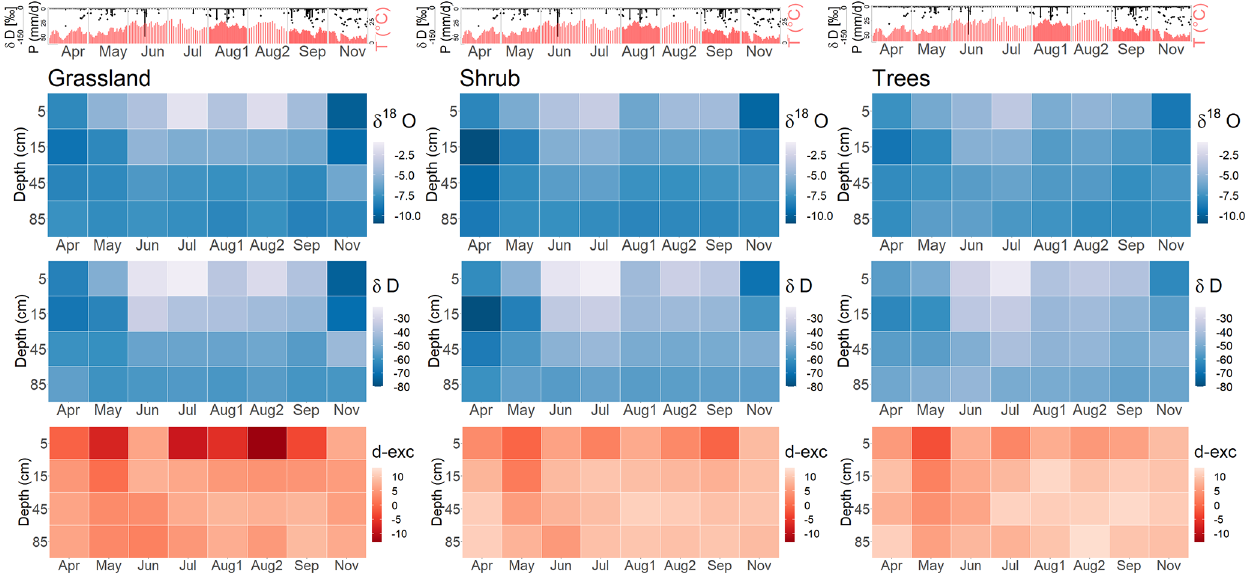
Figure 5. Heat maps showing the isotopic composition of the different soil layers during the monthly sampling campaigns (for abbreviations, see Table 3) in ‰ VSMOW. Climate parameters (top; DWD, 2020a) mark the daily T air and P during the sampling period.